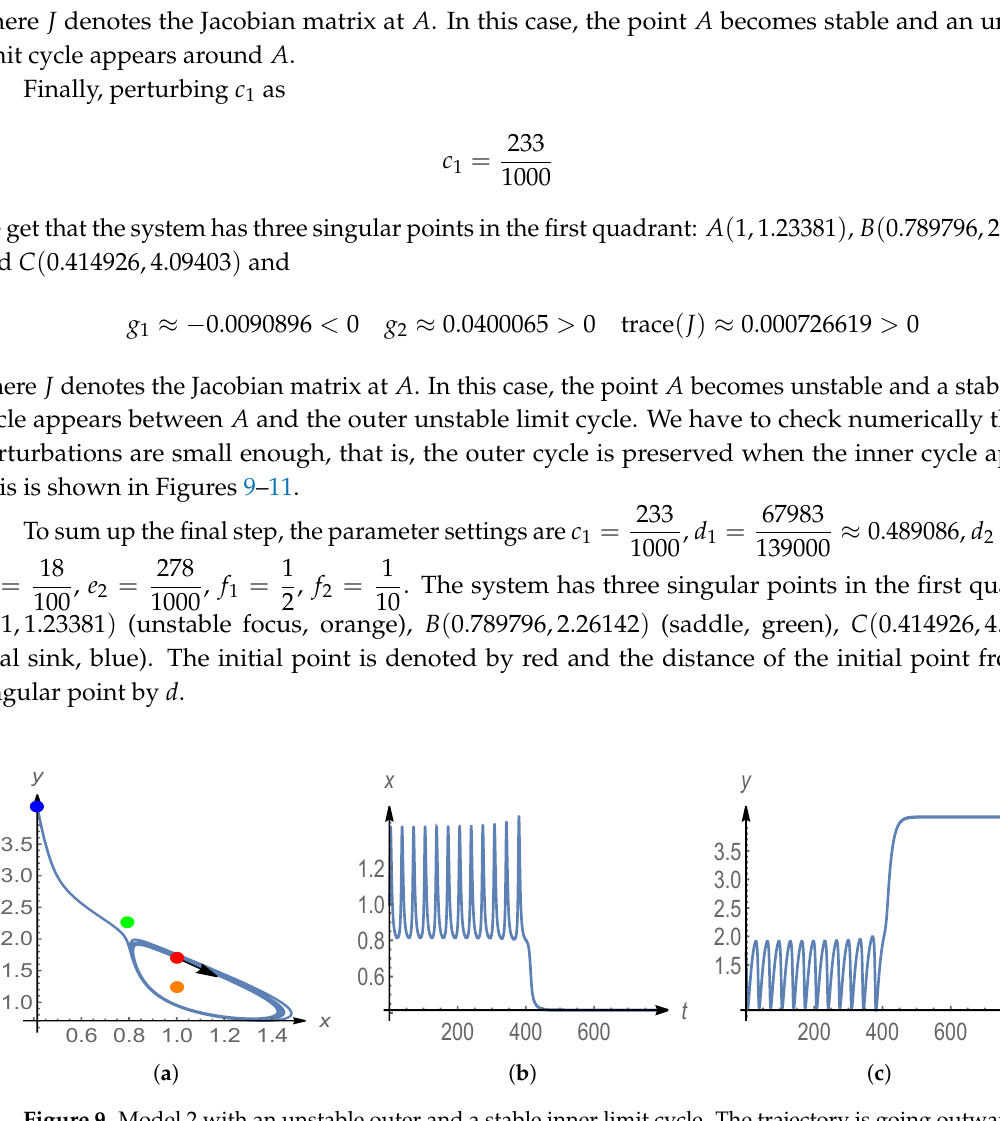
Figure 9. Model 2 with an unstable outer and a stable inner limit cycle. The trajectory is going outward, approaching the point C as t → ∞ and the outer limit cycle as t → − ∞ ( d =